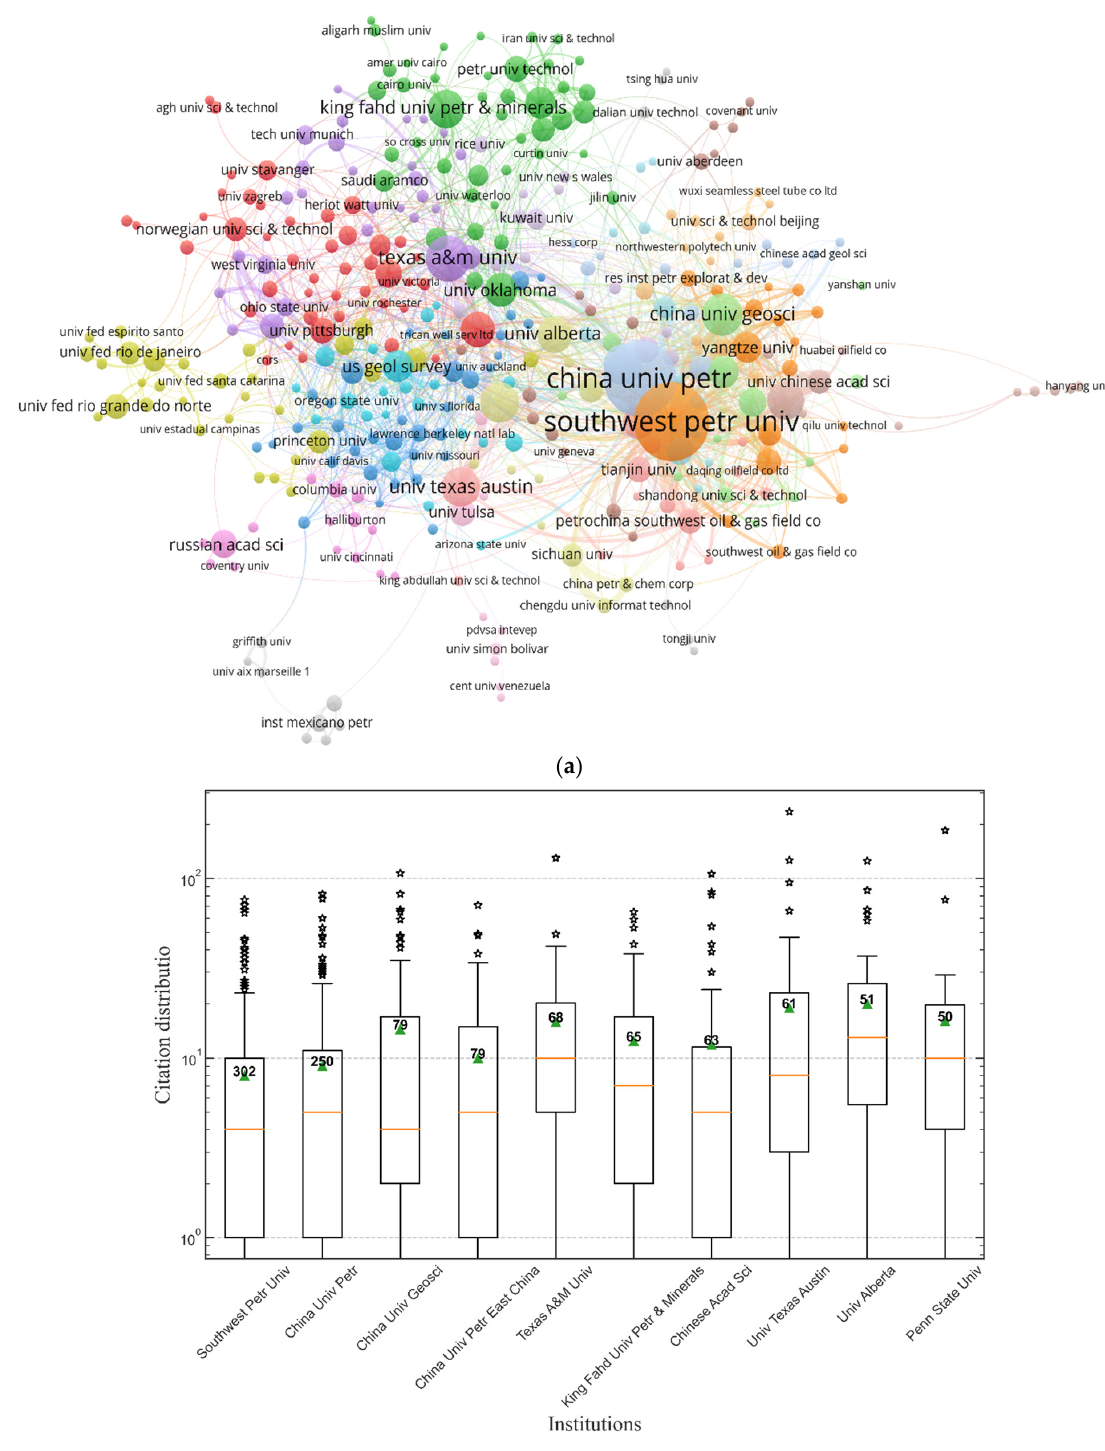
Figure 10. ( a ) The giant connected component of the institutional collaboration network with at least five papers generated by VOSviewer. ( b ) The top 10 most scientific influence corresponding institutions. The asterisk in figure indicates the